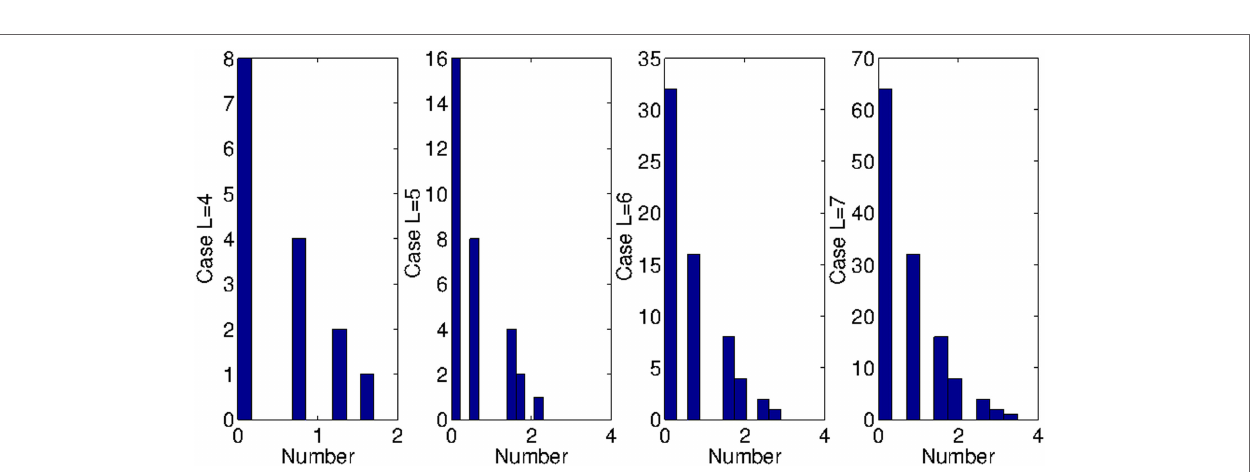
the AC mode is longer than the inverse of twice the thermalization time, then in the negative voltage part of the generator, the node entropy becomes zero. This is shown for instance in Figure 6